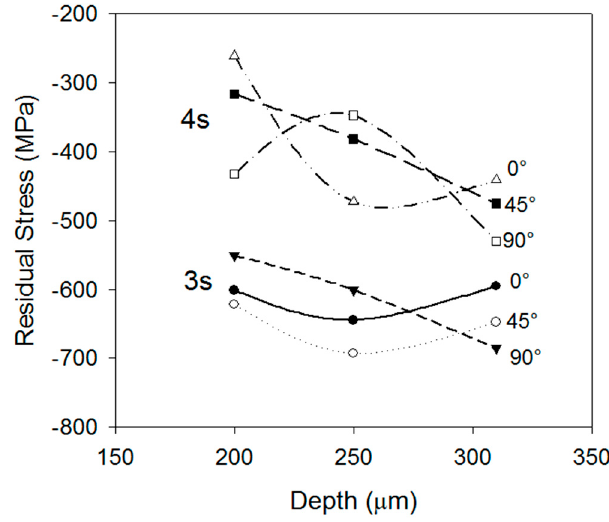
Figure 10. Residual stress profile of the conditions of 3 s and 4 s.